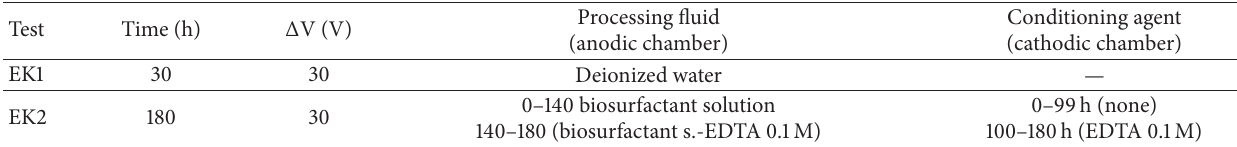
Figure 3: Experimental apparatus. Table 3: Experimental matrix for EK tests.